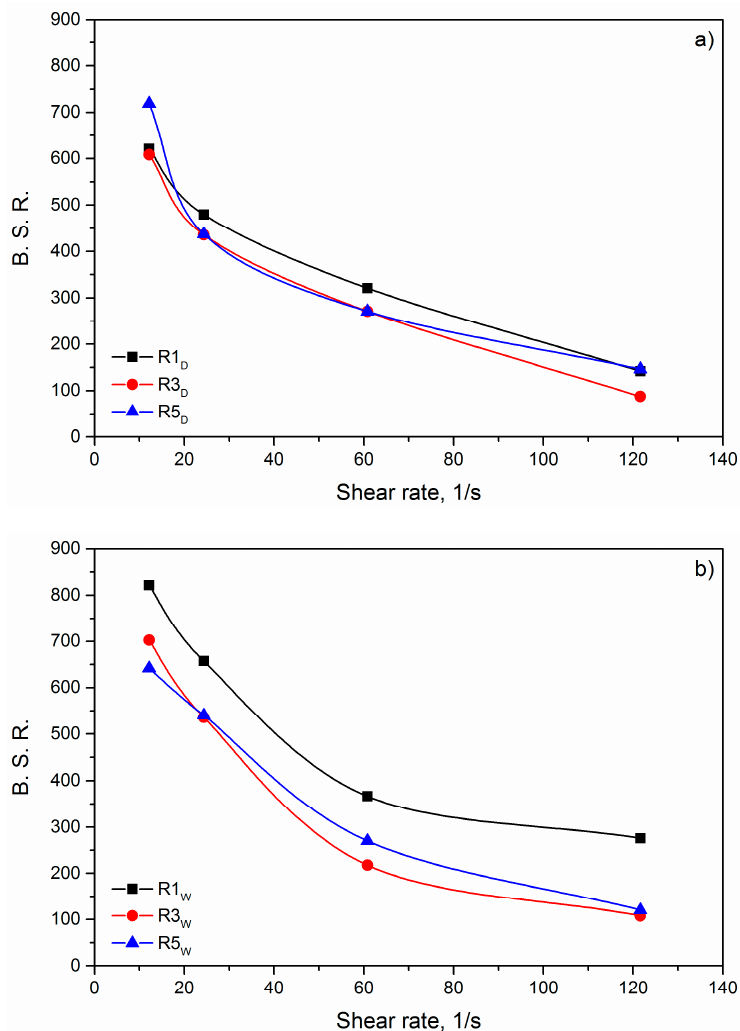
Figure 3. Breaking stretching ratio (BSR) as a function of the apparent shear rate for ( a ) dried sample and ( b ) wet sample.